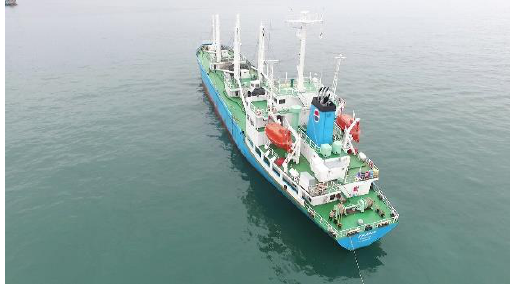
Figure 3. Ship Images Included in the MTMnet Dataset.